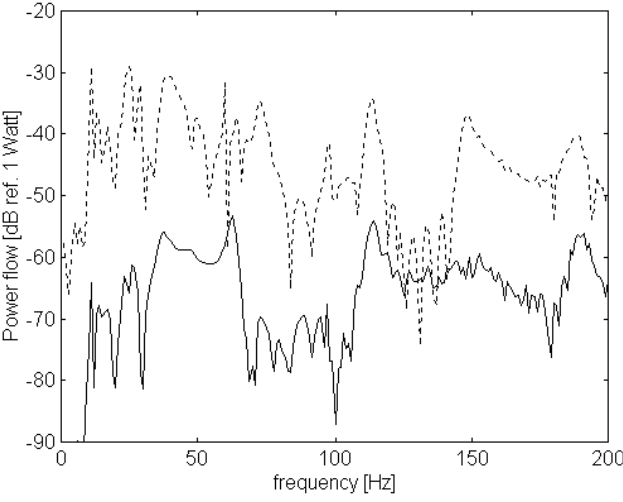
Fig. 4. SI components measured using PVDF patches. — Flexural SI; ··· longitudinal SI.